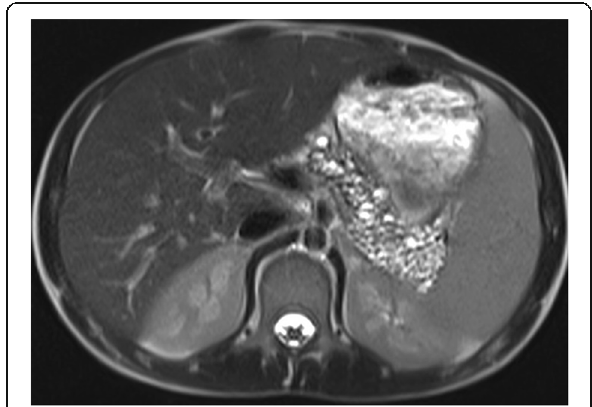
Fig. 26 A 13-year-old male patient with known CF and pancreatic insufficiency. Axial plane T2W MR image reveals innumerable cysts of subcentimeter size scattered throughout the pancreas, almost completely replacing the parenchyma